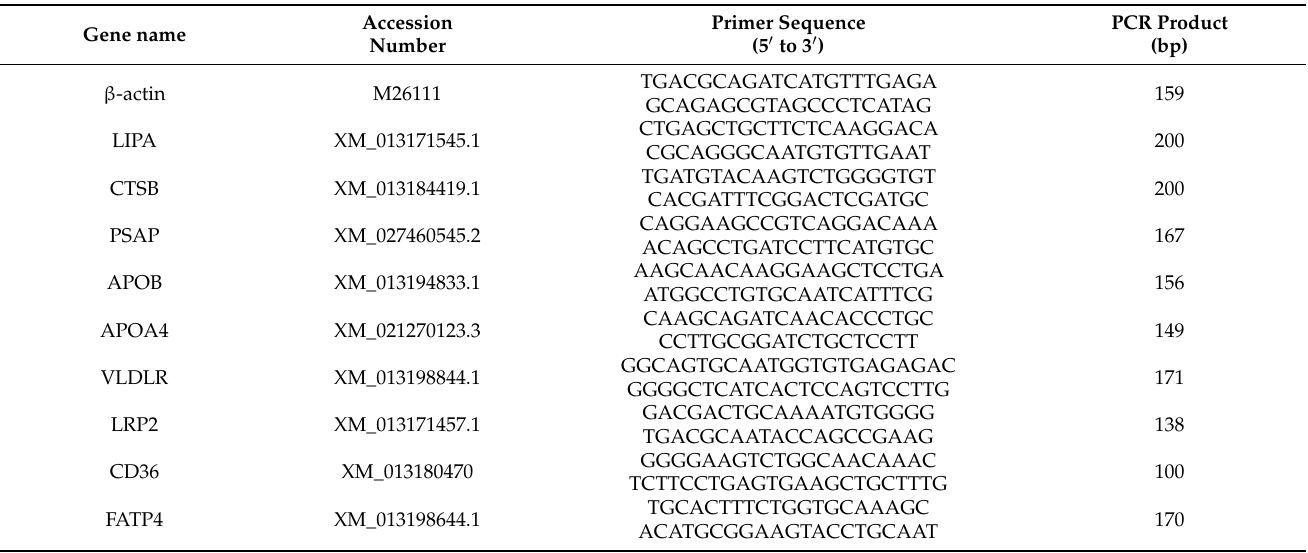
Table 1. Primer sequences for